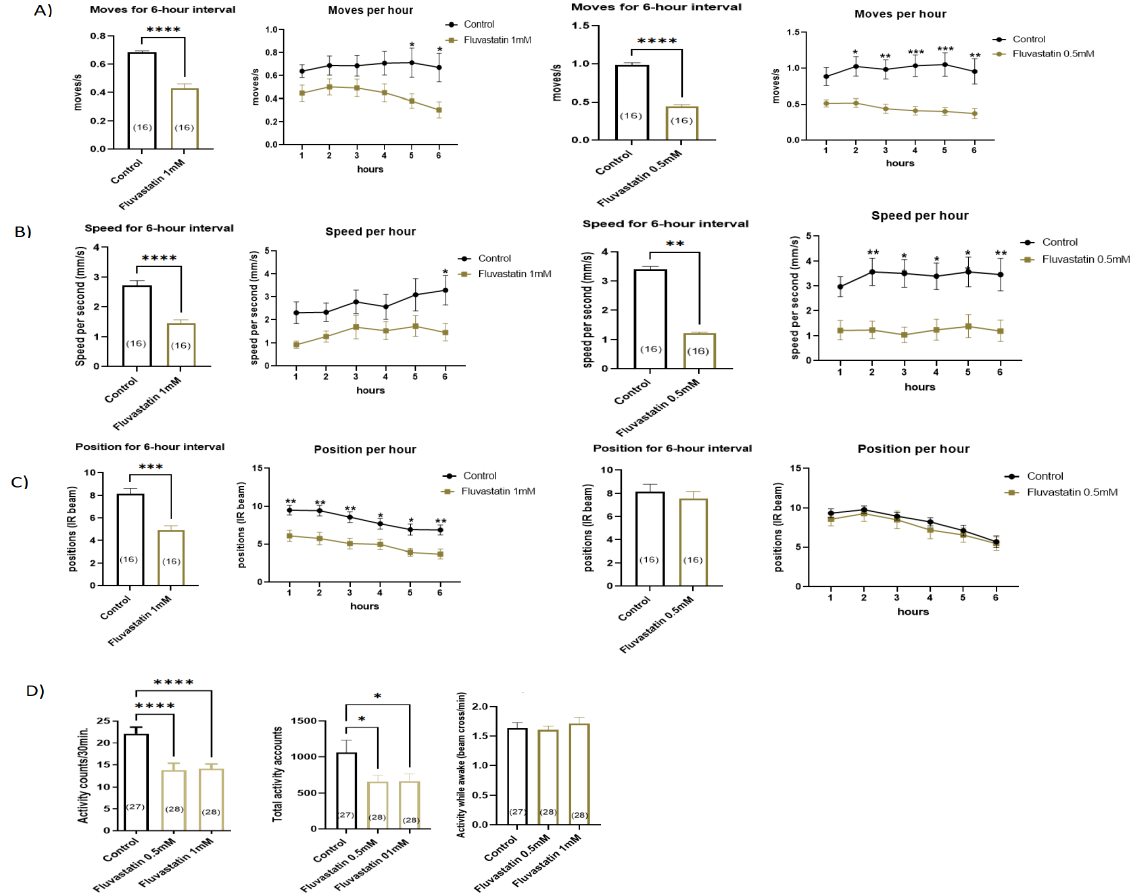
Figure 2. Fluvastatin treatment-induced lower climbing ability and general locomotion activity in CSORC flies. In 0.5 and 1 mM fluvastatin groups, flies were fed with food mixed with a corresponding volume of fluvastatin, while in control groups, flies were fed with food, all for five days before they exercised in the Forced-Climbing System for six hours ( A ) the histograms show the average moves for a combined six-hour interval and per hour, ( B ) the histograms show the average speed for a combined six-hour interval and per hour, and ( C ) the histograms show the average position for a combined six-hour interval and per hour. Using DAMS, flies were treated with 0.5 mM or 1 mM fluvastatin mixed with food in the fluvastatin groups, whereas in the control group, flies were treated with food only, both for five days ( D ) the histograms show the general locomotion activity (activity counts/30 min and total activity) and activity while awake of the flies. The Shapiro–Wilk tests were used to check normality where a parametric test was used for normally distributed data and a non-parametric test for non-normally distributed data. The statistical difference between the three groups was calculated using one-way ANOVA with Bonferroni’s multiple comparisons for normally distributed data and Kruskal–Wallis one-way tests for otherwise data. For two groups, except for moves, speed and position per hour where two-way ANOVA with Bonferroni’s multiple comparisons test was used, Student’s t -test or Mann–Whitney test was used to calculate statistical difference according to the normality test whereby * p ≤ 0.05; ** p ≤ 0.01; *** p ≤ 0.005; **** p ≤ 0.0001. In each histogram, the bars represent the mean values ± SEM and the number of flies is indicated in brackets.